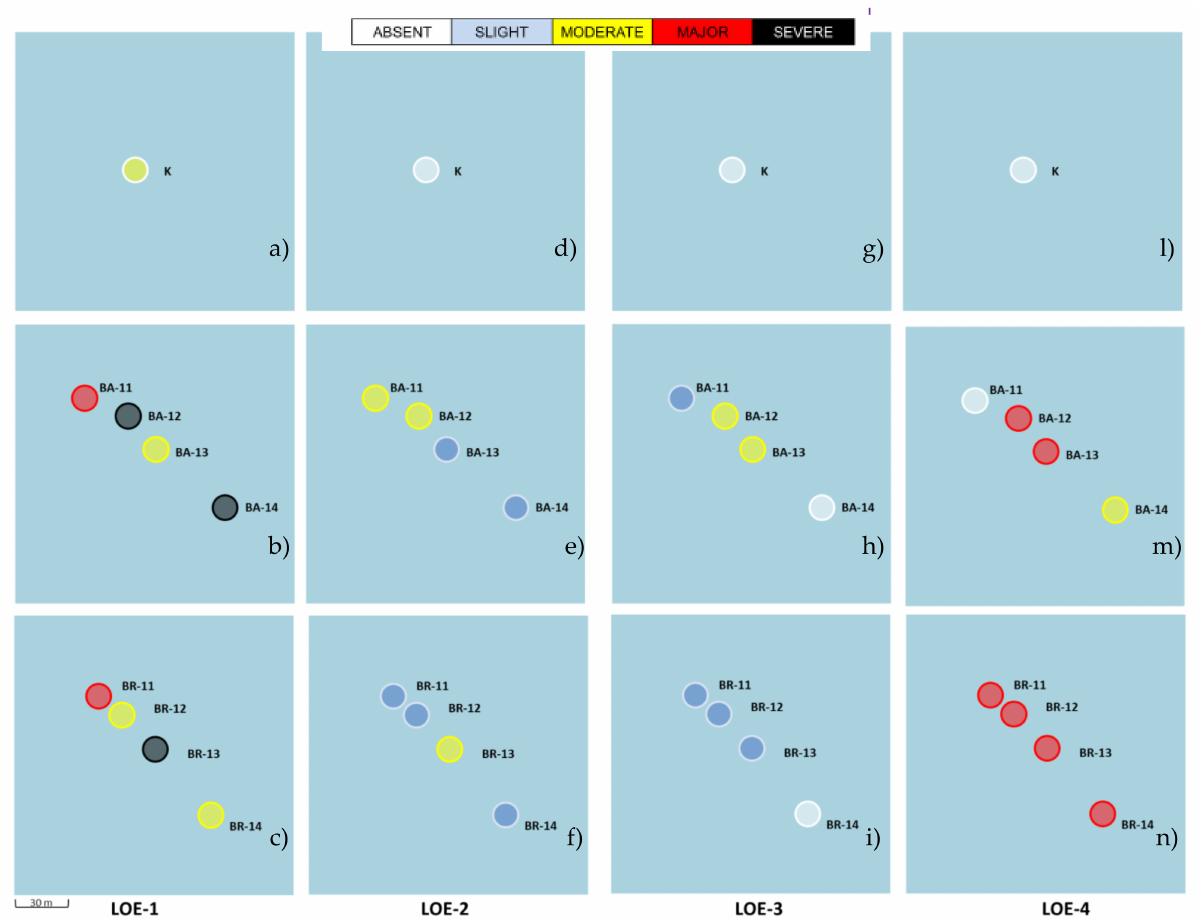
Figure 2. A map of the hazard level for sediments sampled around offshore platforms called BA and BR and reference area K, according to the weight of evidence elaboration. Levels of hazard are reported for each LOE (LOE1 (weighted criterion: EQS values): ( a – c ); LOE2: ( d – f ); LOE3: ( g – i ); LOE4: ( l – n